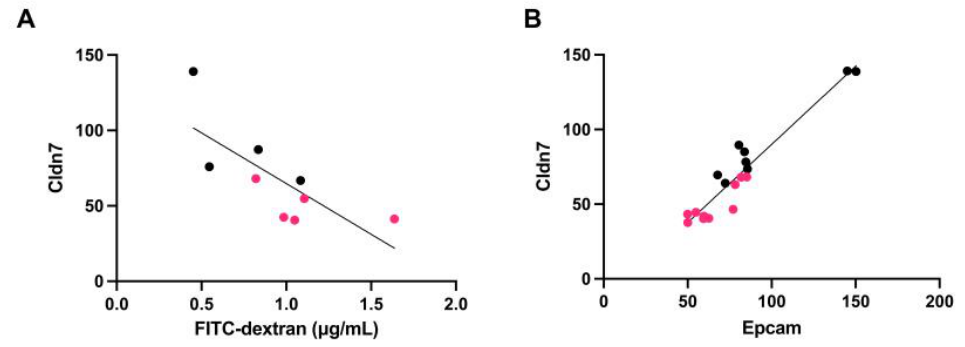
Figure 7. Correlations of claudin (Cldn)7 with intestinal permeability ( A ) and Epcam ( B ). Red and black dots indicate samples from HFD- and CD-fed mice, respectively (A; n = 4, CD group; n = 5 HFD group, B; n = 8, CD group; n = 10).